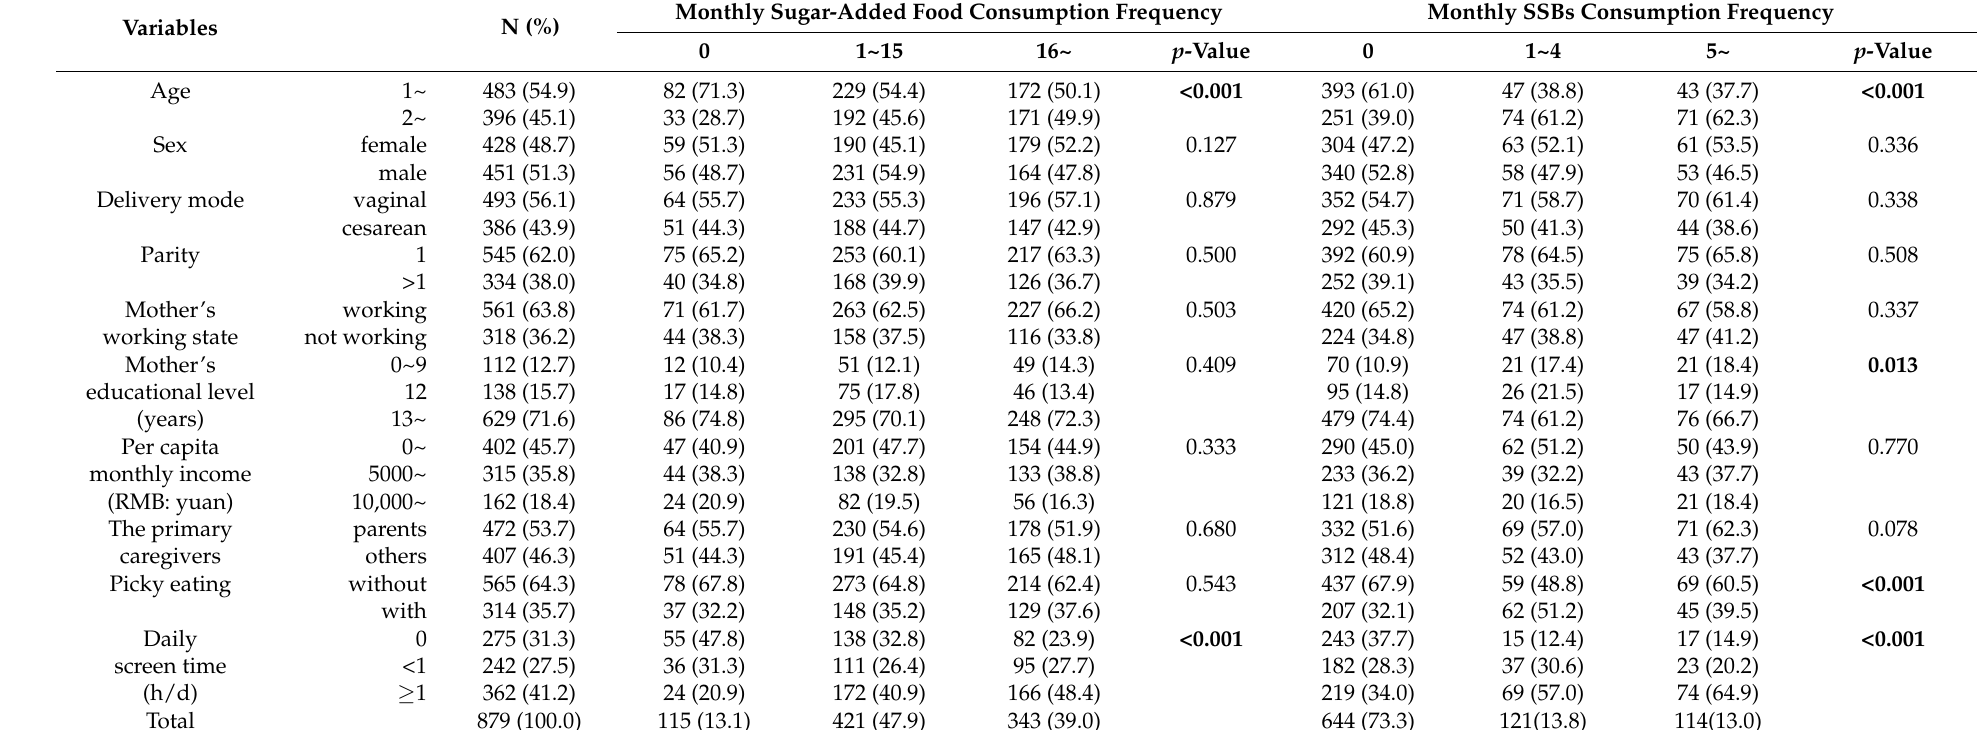
Table 1. Monthly consumption frequency of added sugar, n